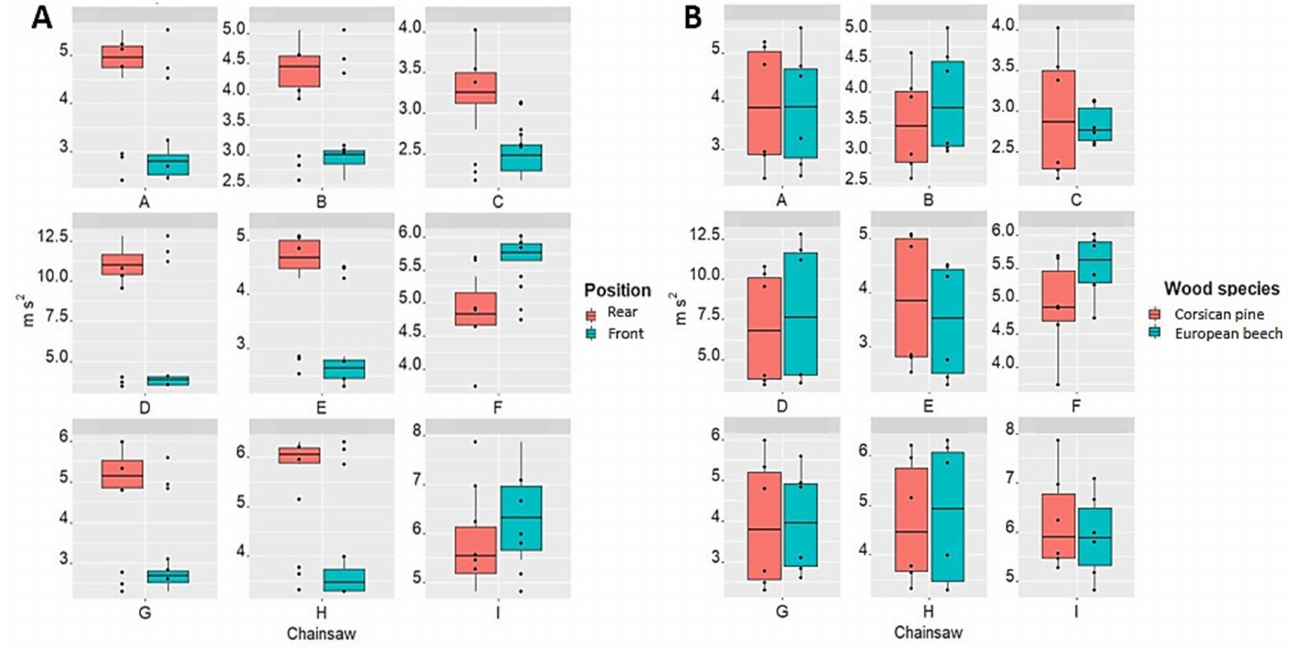
Figure 4. The graphical representation of the vibration peak level a pl during minimum and max- imum RPM (case i ) ( A ) and during cross-cutting operation ( B ) (case ii ) where A–I represent the chainsaw